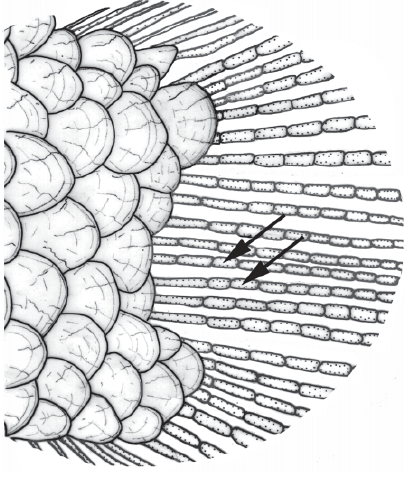
Fig. 4 . Lophiobrycon weitzmani , paratype, LIRP 4338, 24.7 mm SL, squamation of central and basal region of caudal fin of adult male, left side, anterior at left. Arrows indicates the basely straight principal caudal-fin rays 11 (above) and 12 (below) supporting a concentration of bead like hypertro- phied glandular tissue (not shown in the illustration) along the borders of its proximal portions.